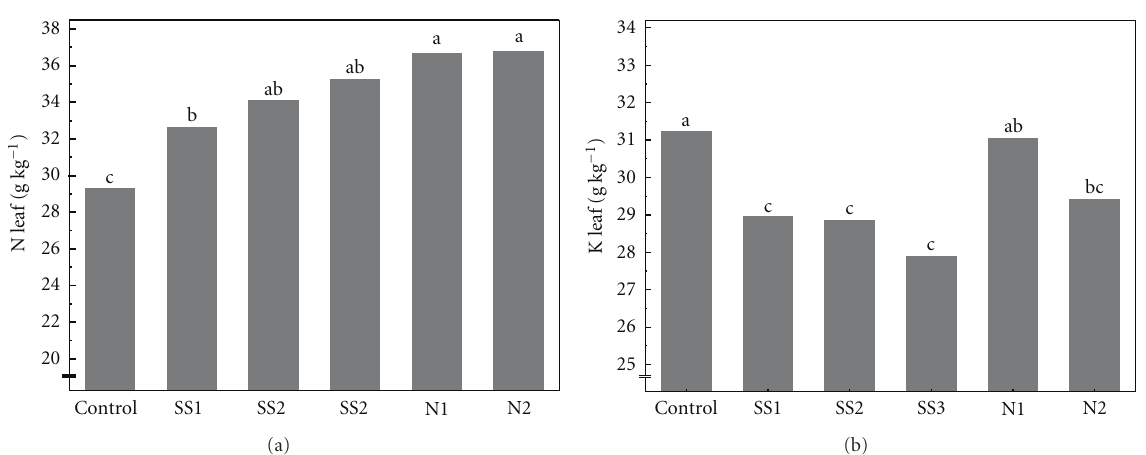
Figure 2: Nitrogen (N) (a) and potassium (K) (b) concentrations of banana index leaves from plots treated with biosolids (SS) and mineral N fertilizer (N). Columns with the same letters indicate that values do not di ff er by the Student’s t -test ( P > . 05).